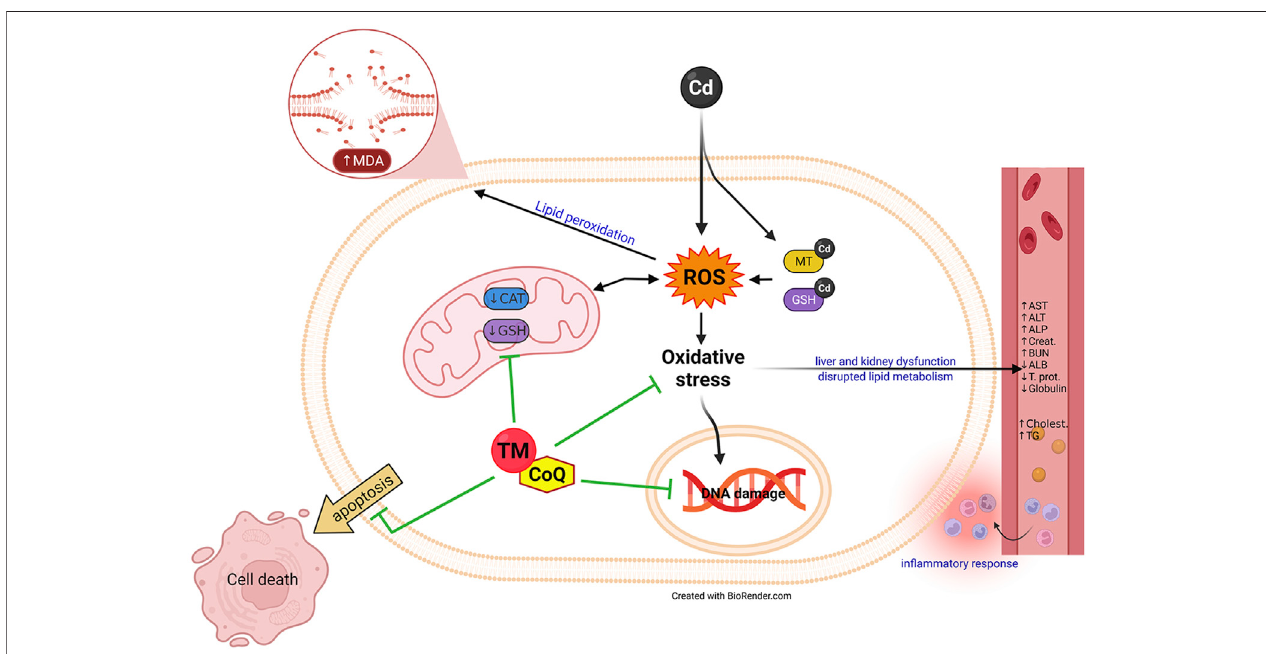
FIGURE 8 | Summary diagram outlines the mechanistic insights underpinning the protective aptitude of TM and CoQ upon Cd-induced hepatorenal damage.